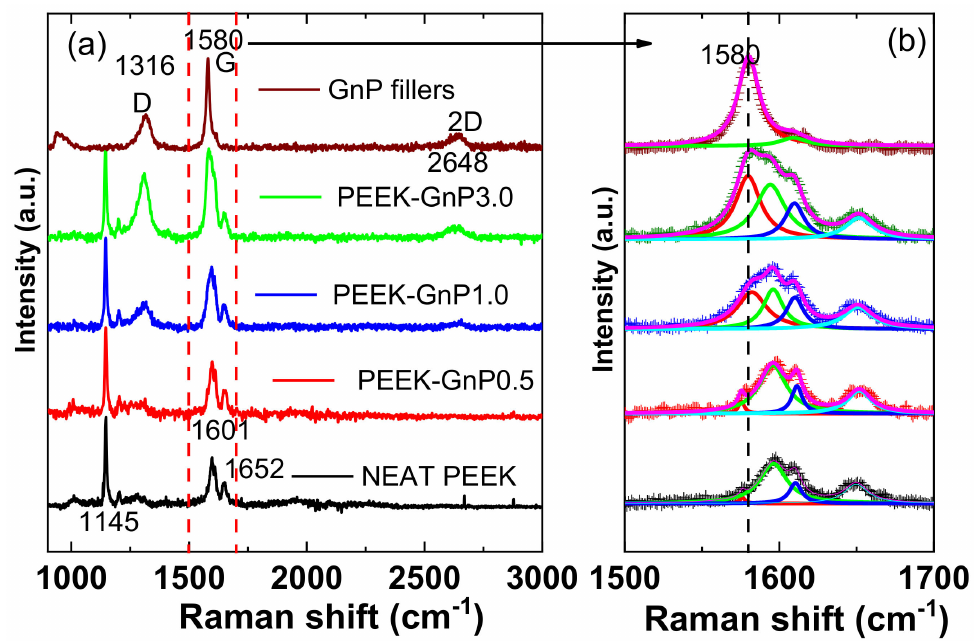
Figure 4. ( a ) Raman spectra of the neat PEEK and PEEK–GnP nanocomposites and ( b ) deconvolution of the overlapped G band of the GnPs and -C=C stretching vibration of the PEEK structure. The red peak is associated with the graphitic G